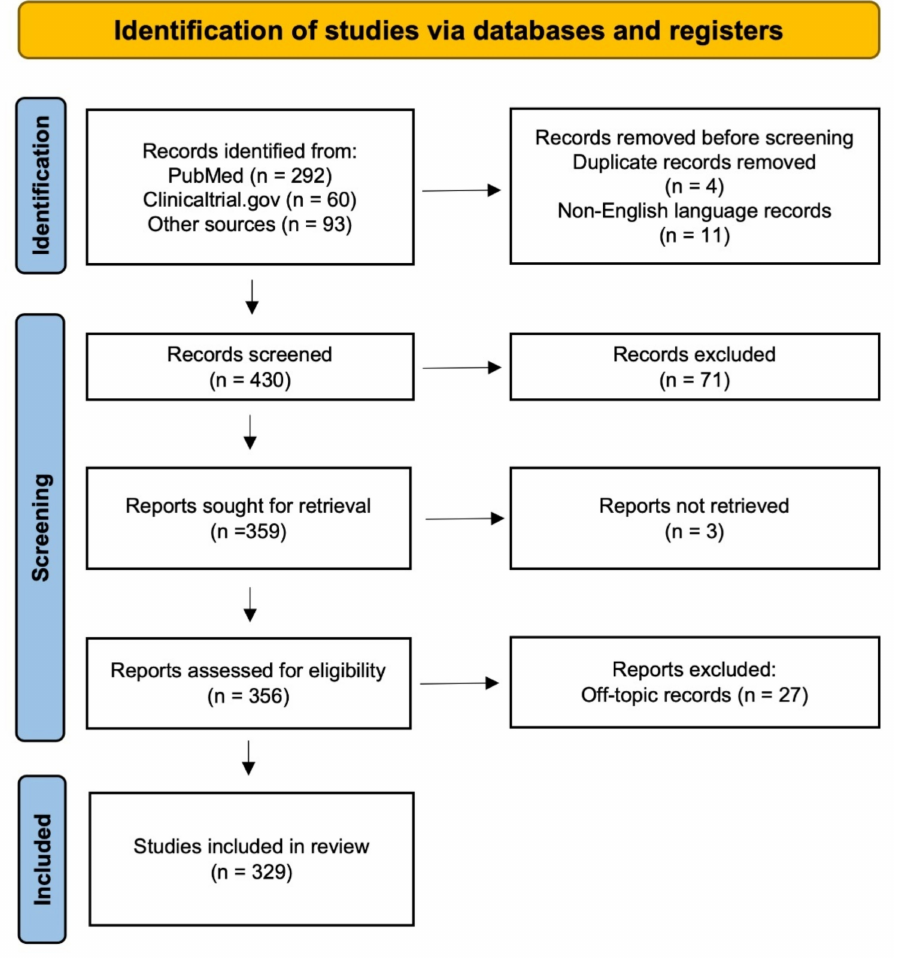
Figure 1. Preferred Reporting Items for Systematic Reviews and Meta-Analyses (PRISMA) flow chart. The diagram details the database searches, the number of abstracts screened, the full-text documents retrieved, and the number of included and excluded